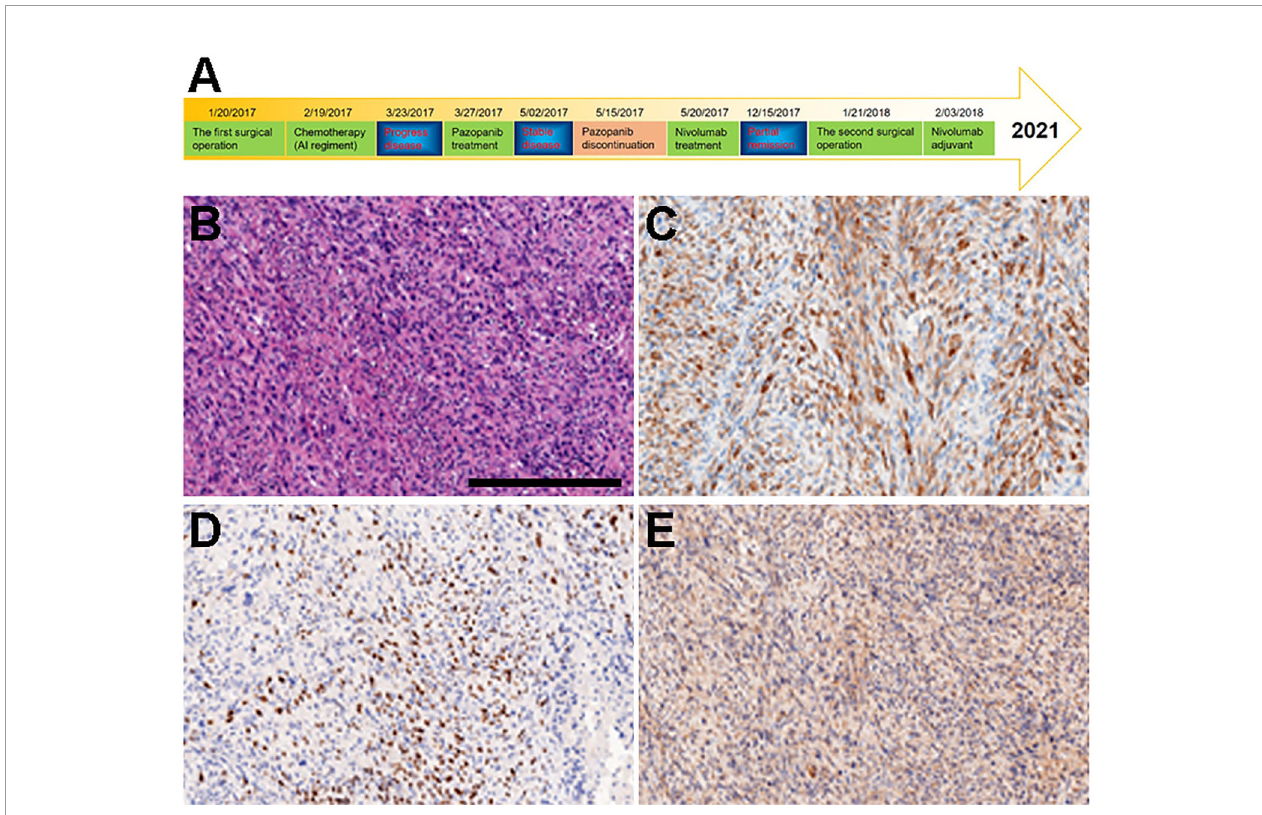
FIGURE 1 | Diagnosis and treatment schematic plot and IHC of primary tumor tissue obtained from surgery. (A) Diagnosis and treatment schematic plot. (B) H&E. (C) DESMIN. (D) MYOD1. (E)